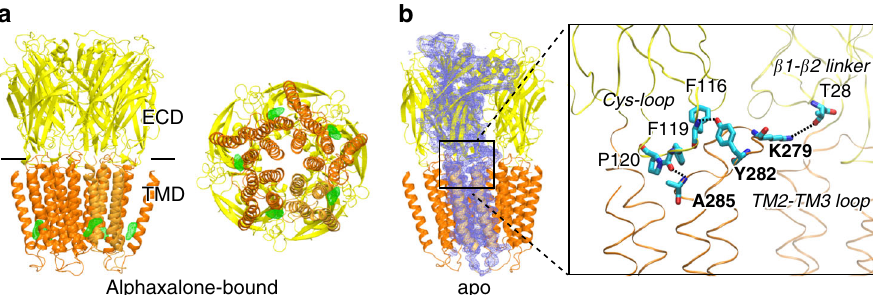
Fig. 2 Crystal structures of the ELIC- α 1GABA A R chimera. a Side (left) and bottom (right) views of the α 1GABA A R chimera in complex with alphaxalone. Alphaxalone binding to the inter-subunit sites in the TMD is indicated by the F O – F C omit electron density map contoured at 4 σ (green mesh). b Side view of the apo α 1GABA A R chimera. One of the fi ve subunits is covered with the 2 F O – F C electron density map contoured at 1 σ (blue mesh). A zoom-in view of the interfacial region shows the representative residue contacts at the interface between the TM2 – TM3 loop and the Cys-loop or β 1 – β 2 linker in the